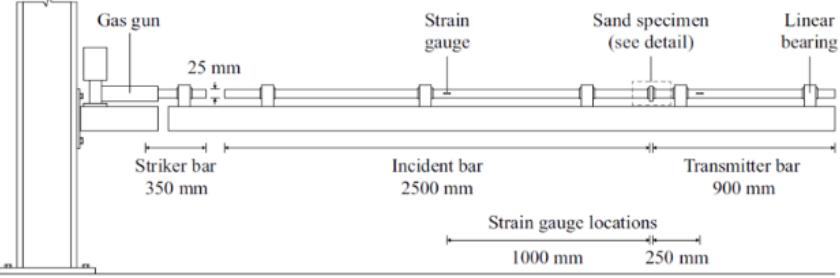
Figure 9. Schematic system of a modified Hopkinson split pressure bar for dynamic loading (reprinted from Ref. [75]).